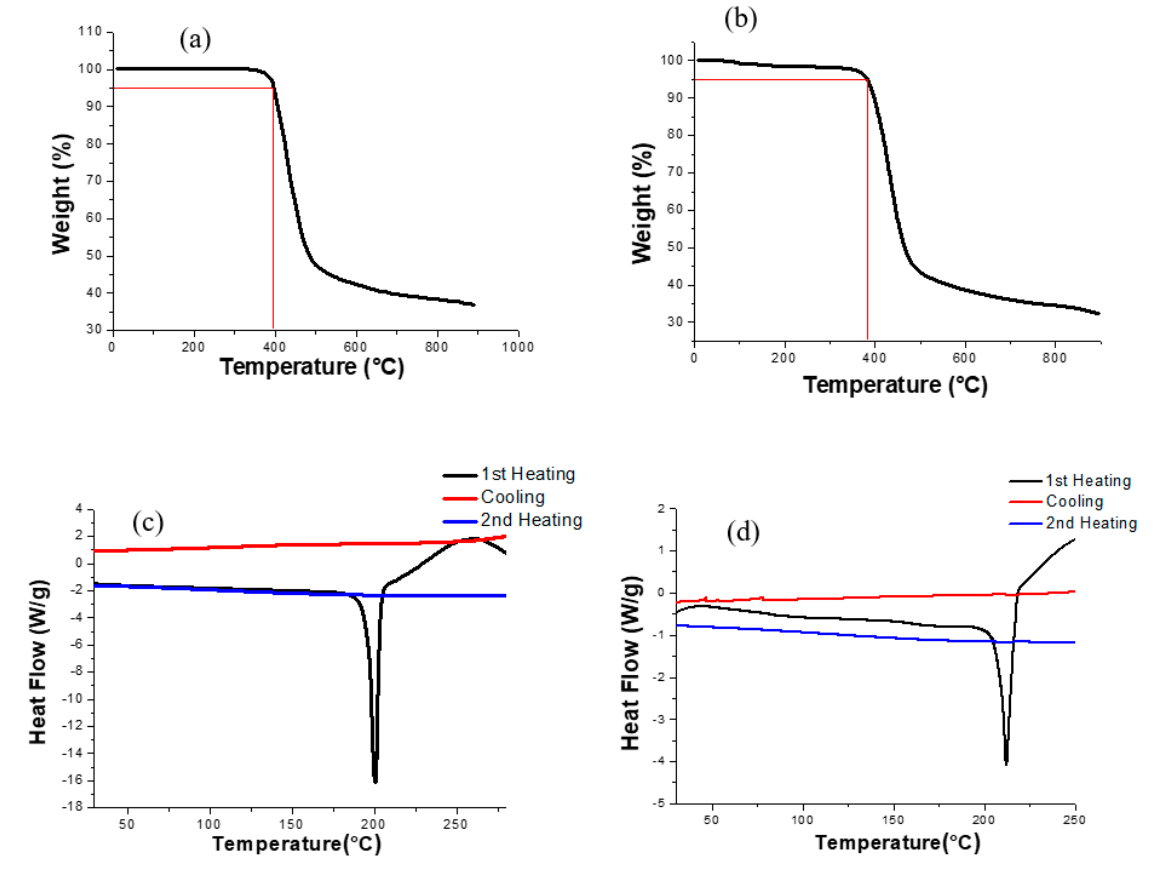
Figure 3. TGA curves of ( a ) TDPP-T and ( b ) TDPP-EDOT, DSC curves of ( c ) TDPP-T and ( d ) TDPP-EDOT .